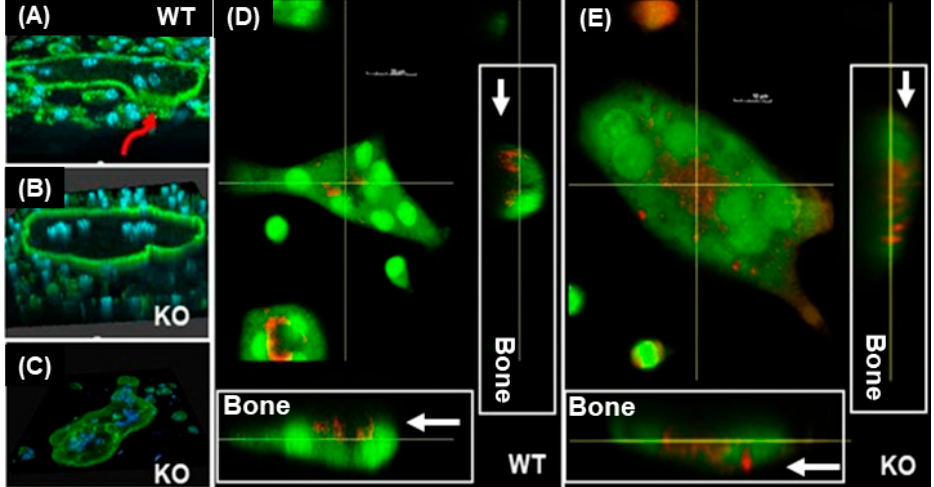
Figure 1. Lack of LRRK1 in osteoclasts disrupts cytoskeletal rearrangement and impairs extracellular acidification. Osteoclasts derived from 4-week-old male mice were cultured on bone slices and labeled with Alexa Fluor-488 conjugated phalloidin and DAPI ( A – C ) or acridine orange ( D , E ). Staining was analyzed by confocal microscopy. ( A ) A wild-type (WT) osteoclast formed a clear actin ring associated with a pit on a bone slice as the red arrow indicates. ( B , C ) 3-D images of LRRK1 knockout (KO) osteoclasts with a disrupted cytoskeleton and an apparent actin ring, respectively, without association with pits. ( D , E ) Horizontal and vertical cross-section images of the live WT and LRRK1 KO osteoclasts stained with the vital fluorescent dye acridine orange. Arrows indicate acridine orange-stained protons from the lysosomes (orange).